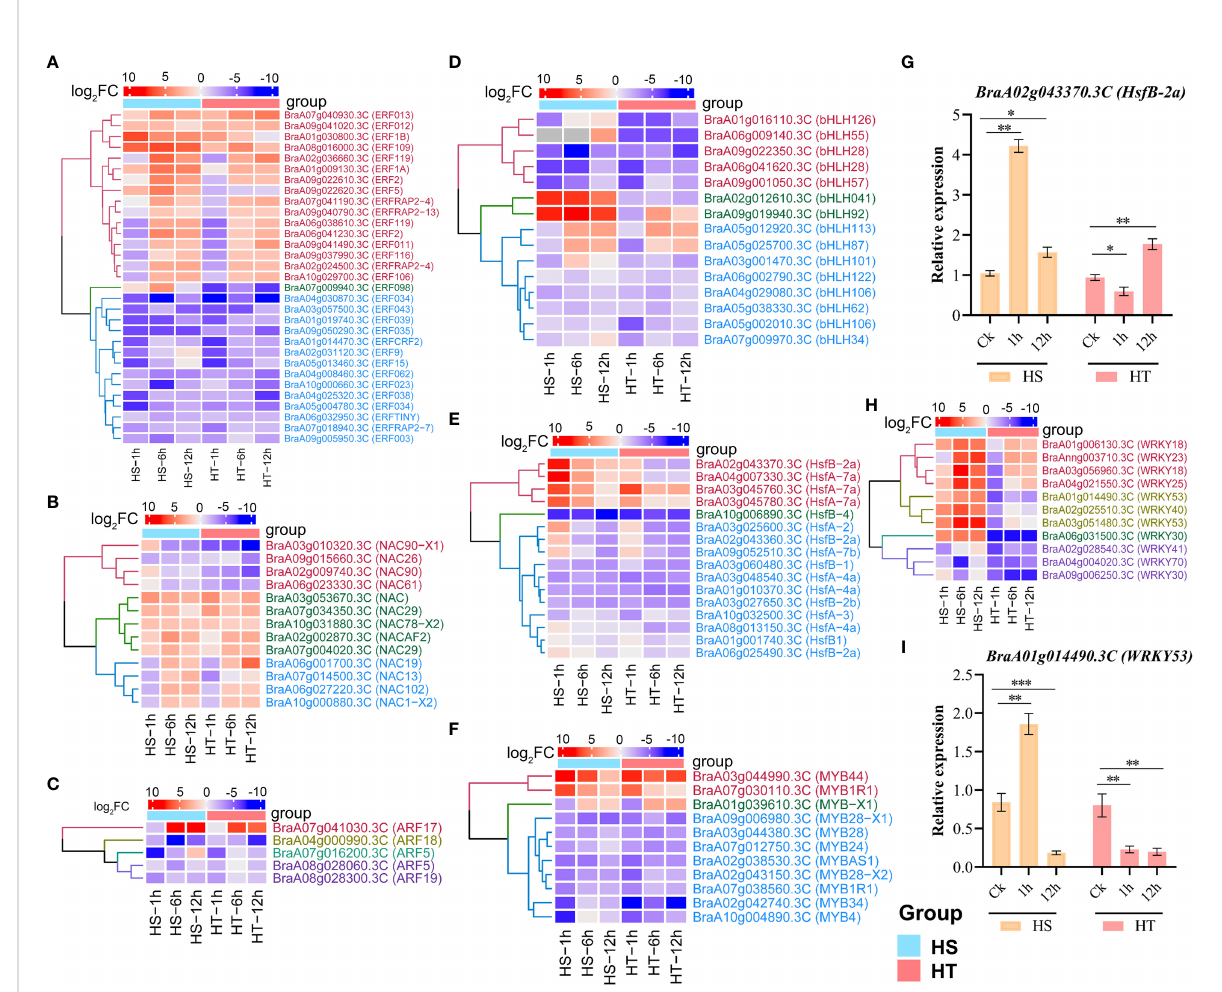
FIGURE 6 Heatmaps of transcription factor families involved in abiotic stress and validation of DEGs in heat-sensitive (3T-6) and heat-tolerant (Youlu-501) fl owering Chinese cabbage using RT-qPCR analysis. The up- and down-regulated genes of TF families: (A) ERFs, (B) NAC, (C) ARFs, (D) bHLHs, (E) HSFs, (F) MYBs, and (H) WRKYs for different high-temperature treatments; (G – I) Con fi rmation of HsfB-2a and WRKY53 using RT-qPCR. Asterisks indicate signi fi cance between treatment and control using Student ’ s t-test at *P < 0.01, **P < 0.01, and ***P <